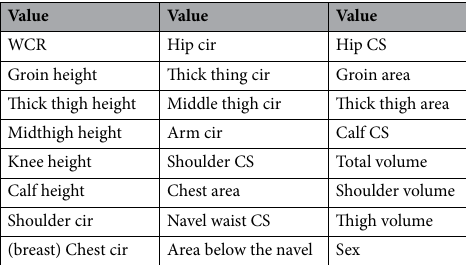
Table 5. Selected features of the “Feature selection Genetic Algorithm”.